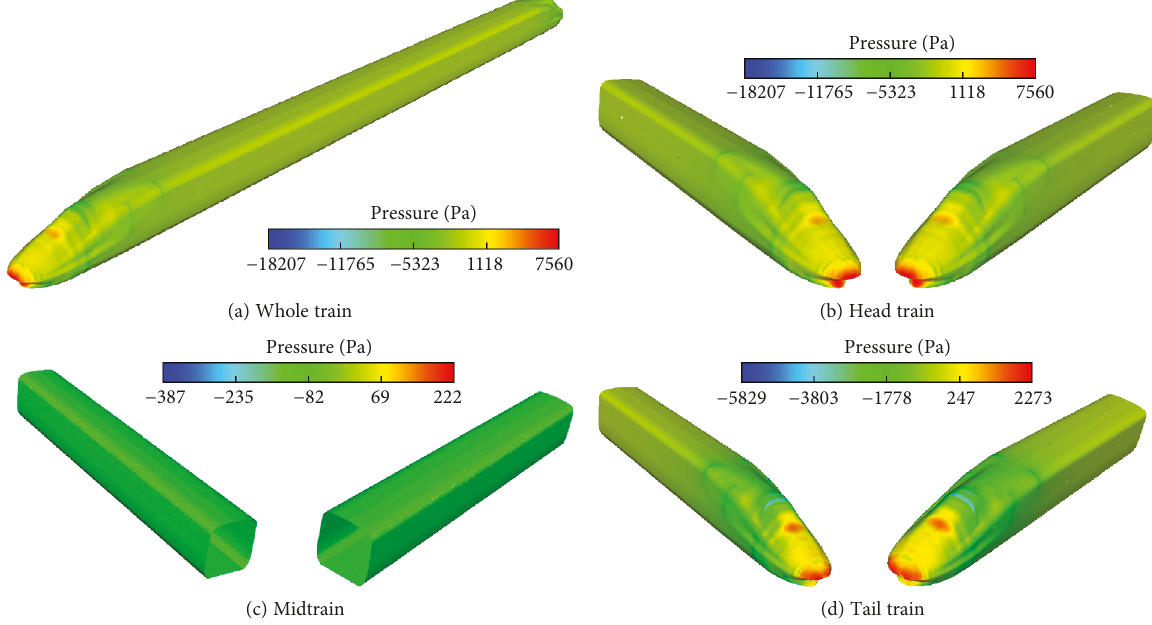
Figure 8: Pressure distribution on the train surface at 1.125s when the high-speed train passed the air